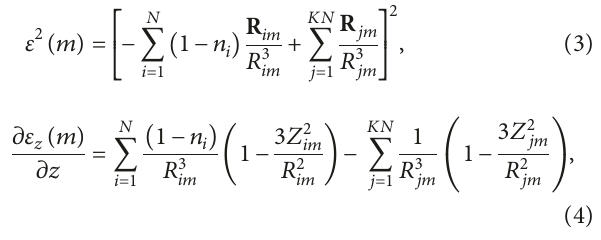
Figure 6: Shape of the 1s dratic Stark effect at H